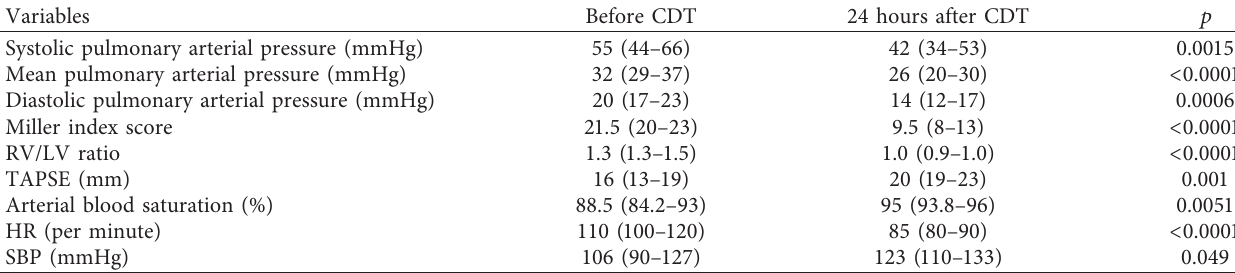
Table 3: Comparison of hemodynamic and echocardiographic outcomes before and after CDT. Variables